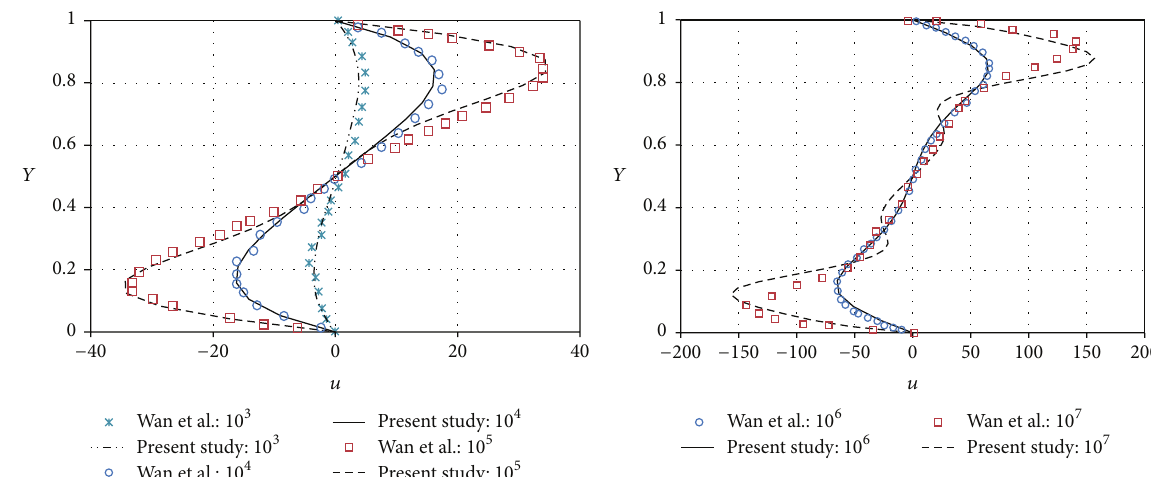
Figure 3: Comparison of grid structures.